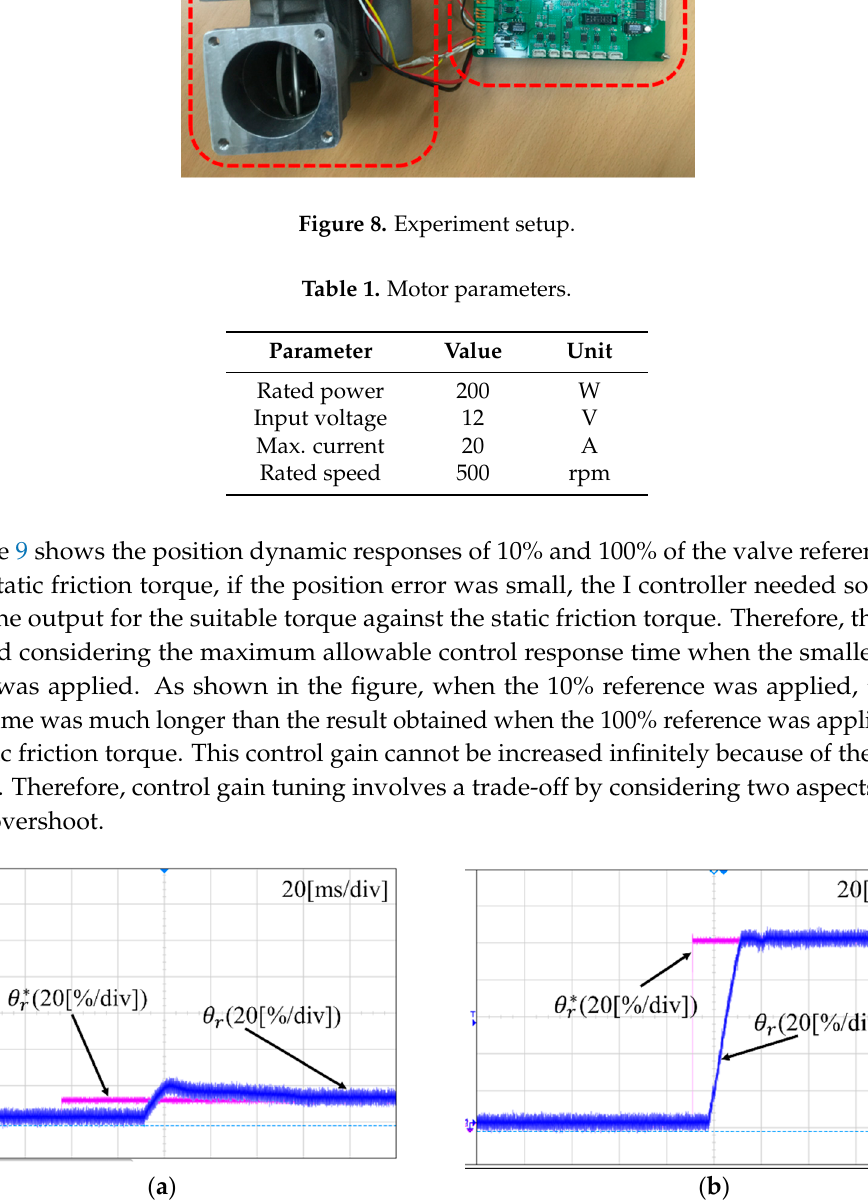
Figure 9. Position dynamic response when a ( a ) 10% and ( b ) 100% valve reference were applied.